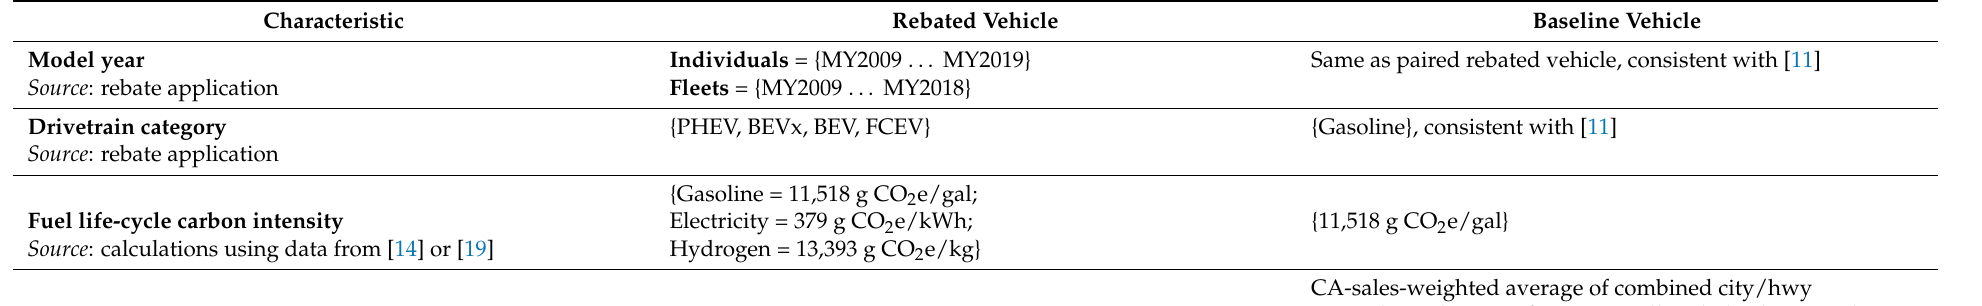
Table 2. Input Values and